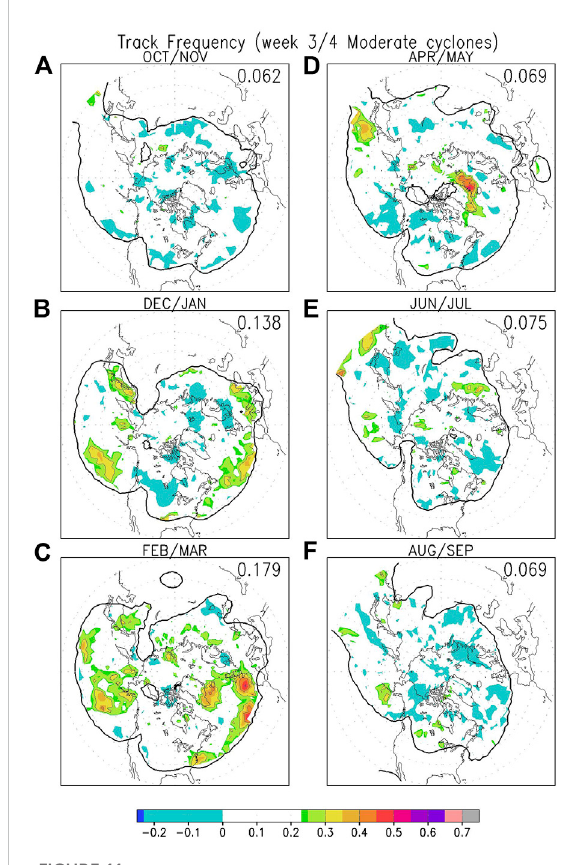
FIGURE 11 Same as Figure 8, but for weeks 3-4 hindcasts of cyclone track frequency of moderate